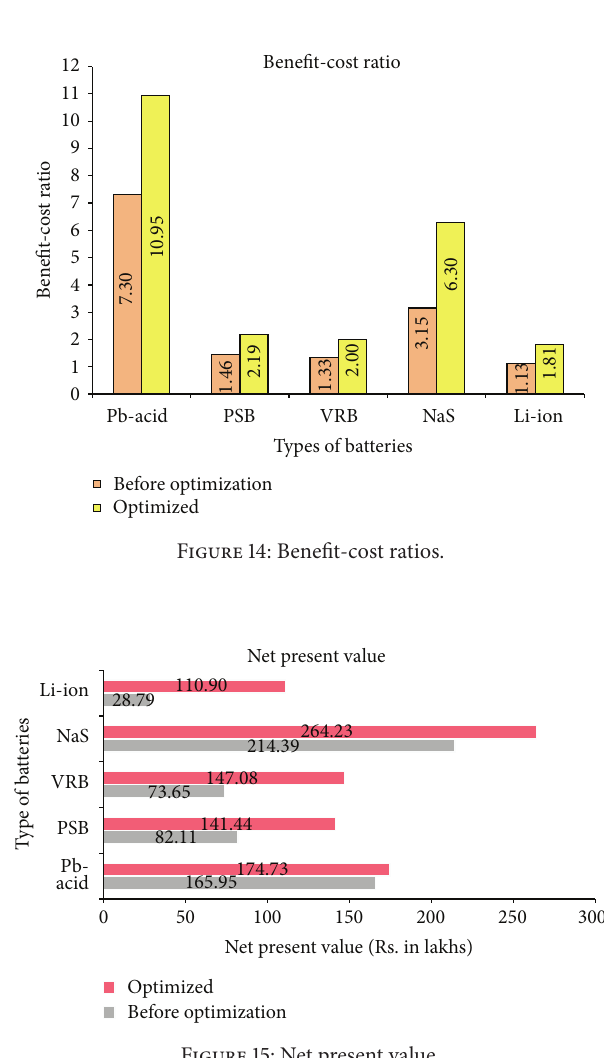
Figure 15: Net present value.